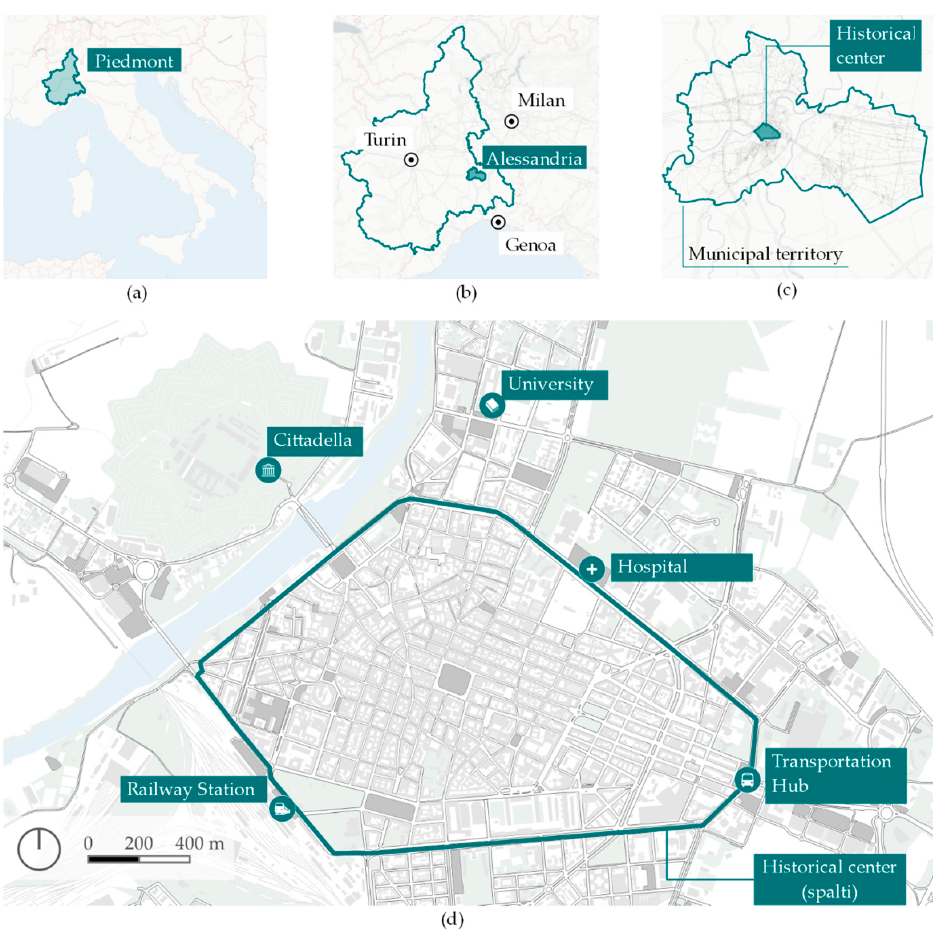
Figure 1. Alessandria is located ( a ) in the North-West of Italy; ( b ) in the middle of the industrial triangle generated by the major cities of Turin, Milan, and Genoa; ( c ) its historical center covers a small part of a wider municipal territory; ( d ) the majority of the green areas are out of the boundaries of the historical center, which is mostly a built environment and its open public spaces are mainly covered by parking areas; however, the size of the historical center is compatible with the concept